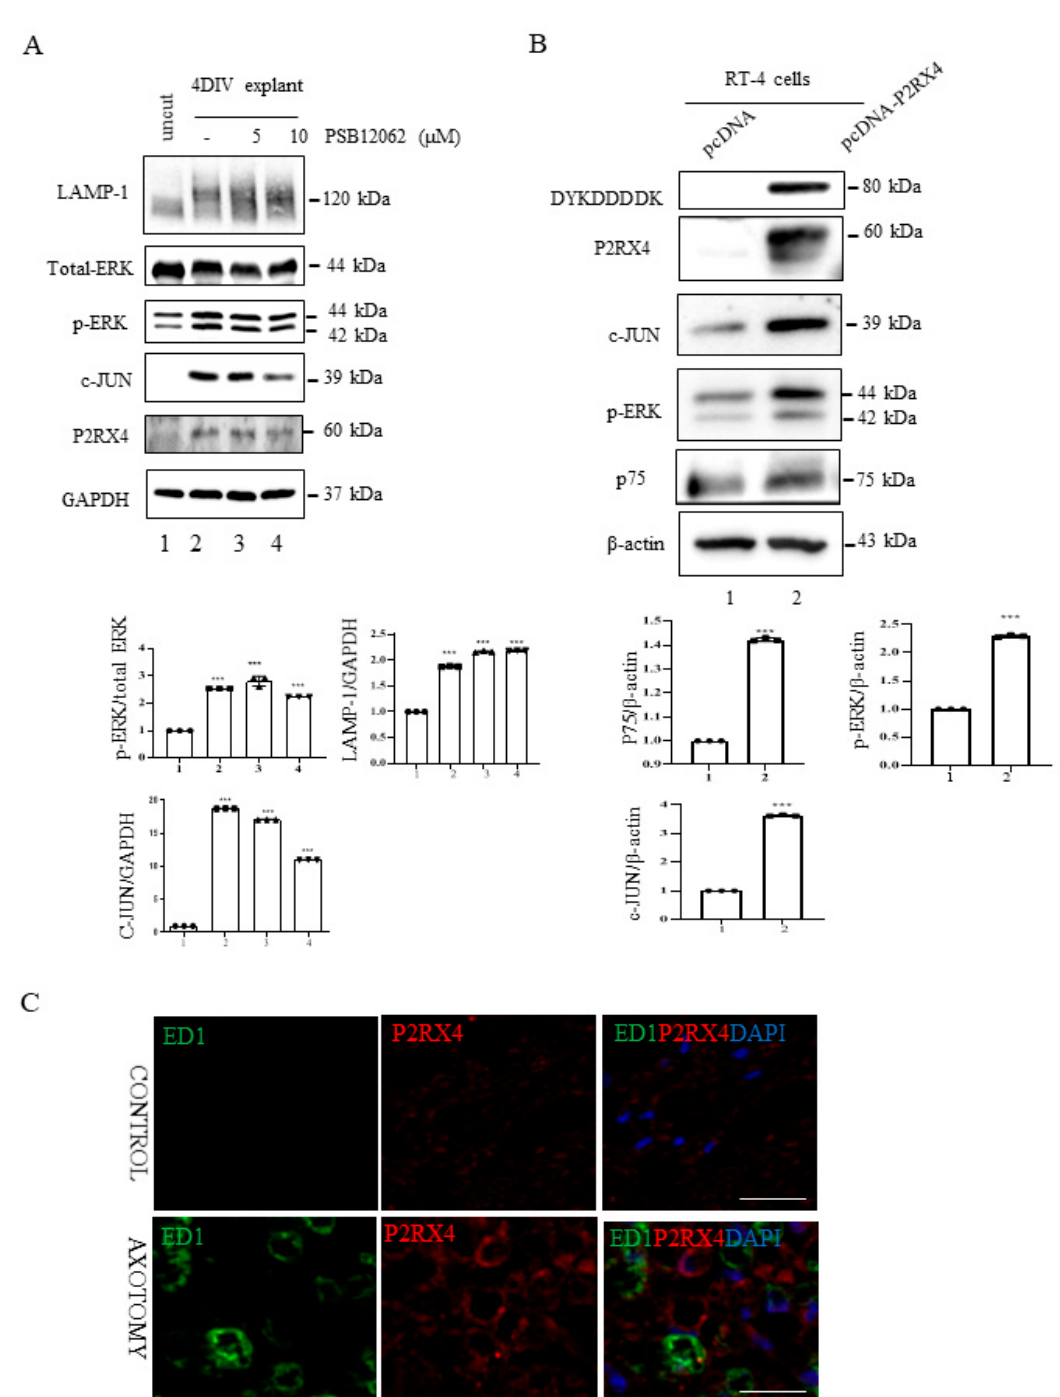
Figure 4. P2RX4 regulates p-ERK and c-JUN. ( A ) Sciatic nerve explants cultured for 4 DIV after P2RX4 antagonist (PSB1062) treatment exhibited decreased c-JUN and pERK levels. After the explants had been cultured, LAMP, ERK, c-JUN, P2RX4, and GAPDH proteins were collected for Western blotting. Uncut indicates freshly isolated sciatic nerves. The lower panel shows the Western blot results. n = 3. ( B ). Overexpression of P2RX4 by transfection with a pcDNA-P2RX4-DYKDDDDK-tagged plasmid enhanced the expression of pERK and c-JUN in RT4 Schwann cells. The lower panel shows the Western blot results. n = 3. Data are the mean ± SD. *** p < 0.001. ( C ) Immunofluorescence signals of P2RX4 (red) and ED1 (green, macrophage marker) in the sciatic nerve at 7 DIV. Scale bar = 20 μ m.